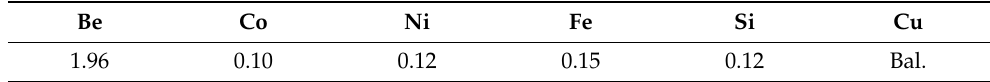
Table 1. The chemical composition of C17200 Cu alloy (wt. %).